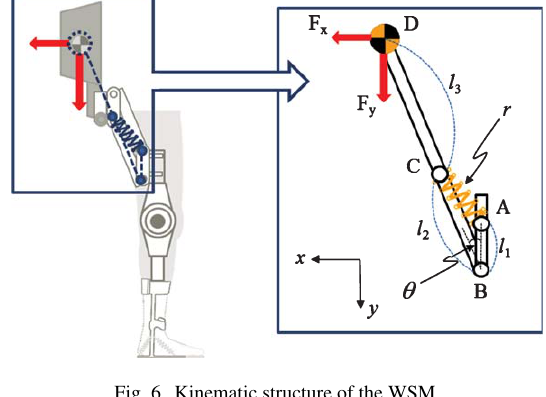
Fig. 6. Kinematic structure of the